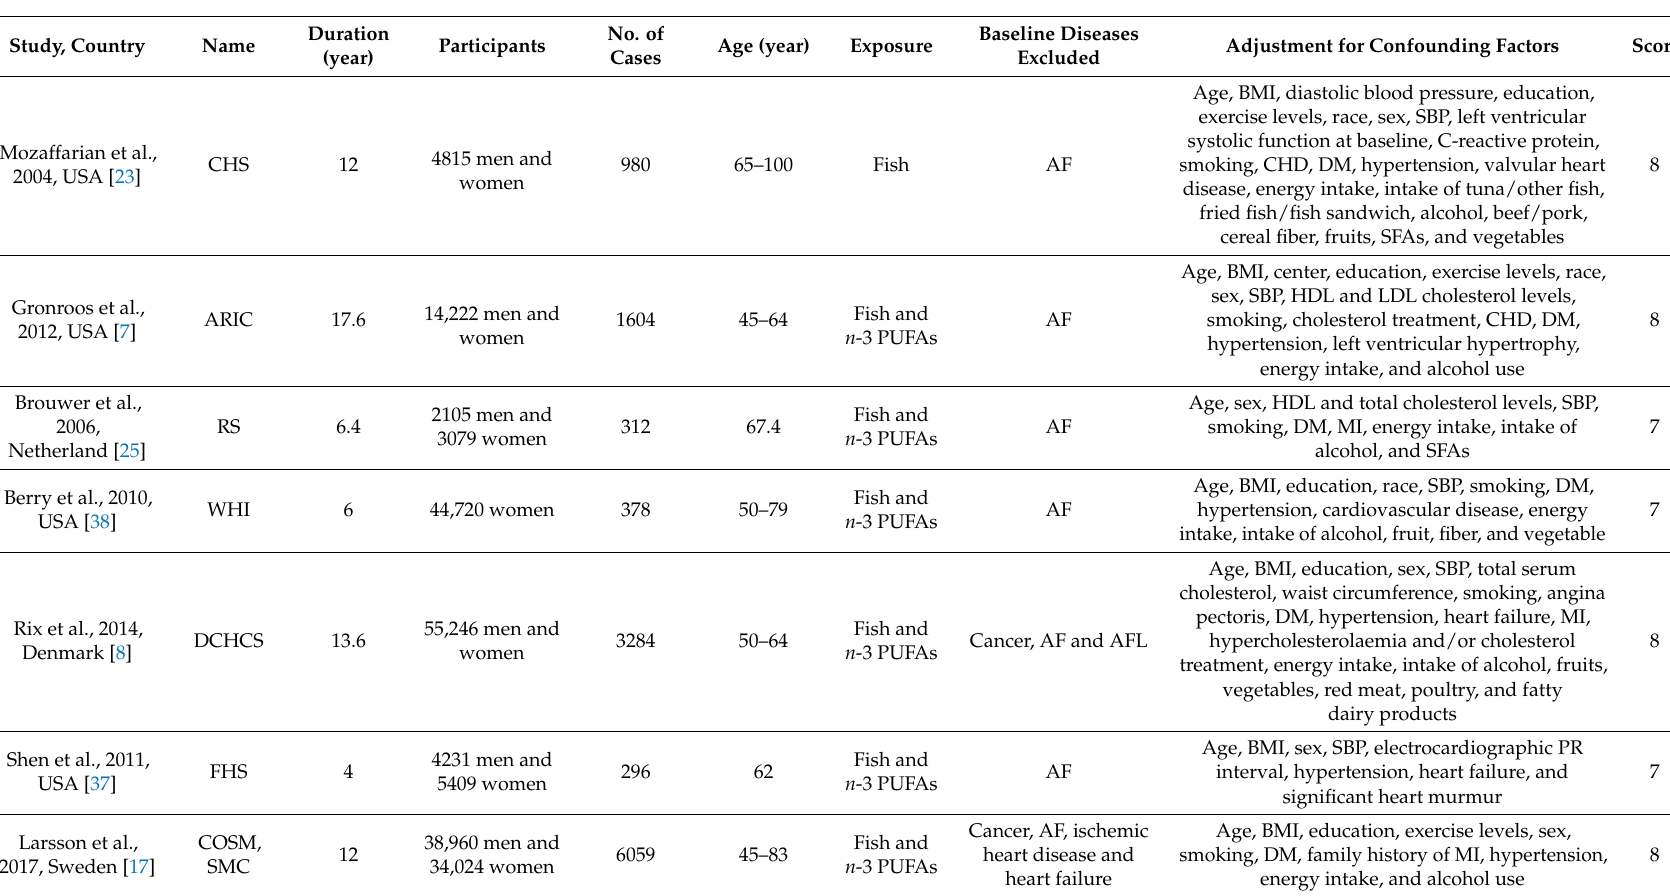
Table 1. Characteristics of included prospective studies that examined the associations of fish consumption and dietary n -3 polyunsaturatedfatty acids (PUFAs) intake with AF